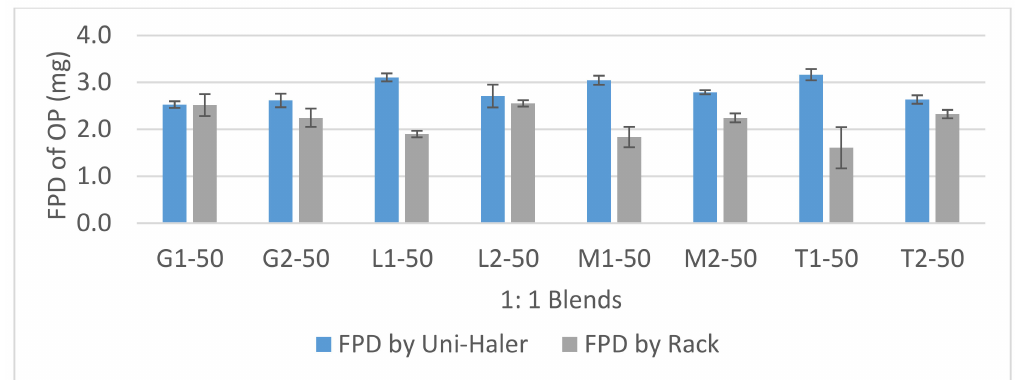
Figure 6. Fine-particle dose (FPD; mg) chart of 1:1 OP / diluent blends aerosolized by the UNI-haler and the Rack. Blends are arranged according to the diluent grade from left to right; micronized glucose (G1), milled glucose (G2), micronized lactose (L1), milled lactose (L2), micronized mannitol (M1), milled mannitol (M2), micronized trehalose (T1), and milled trehalose (T2). Error bars based on calculated standard deviation from the mean ( n =